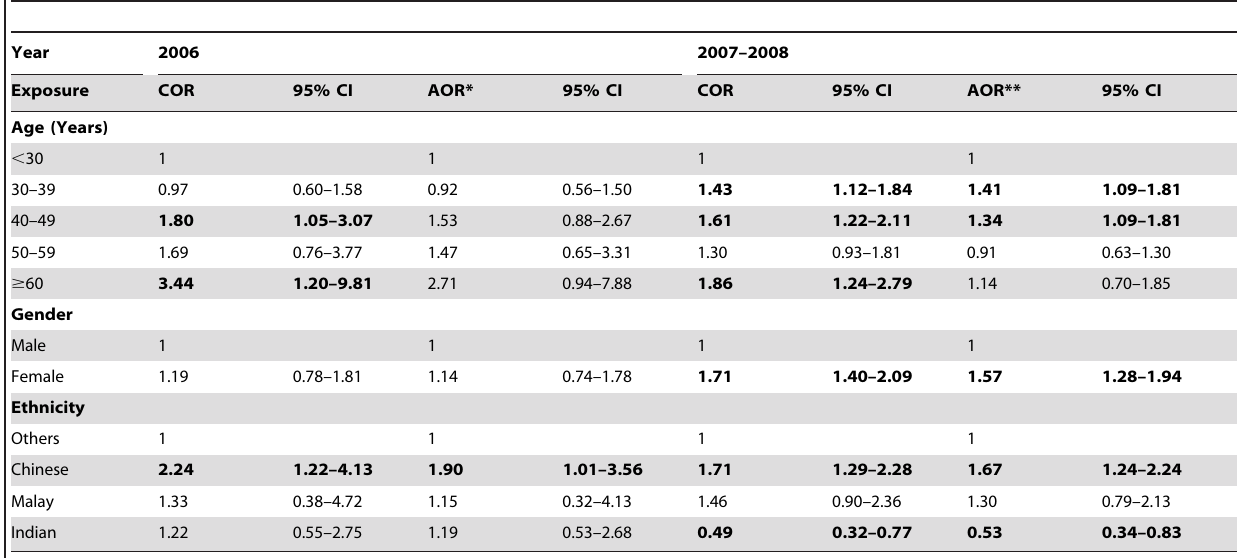
*Adjusted odds ratio was obtained from a multivariate logistic regression being adjusted by age groups and ethnicity. **Adjusted odds ratio was obtained from a multivariate logistic regression being adjusted by age groups, gender, ethnicity, diabetes mellitus and hypertension. DHF- Dengue Hemorrhagic Fever. COR- Crude odds